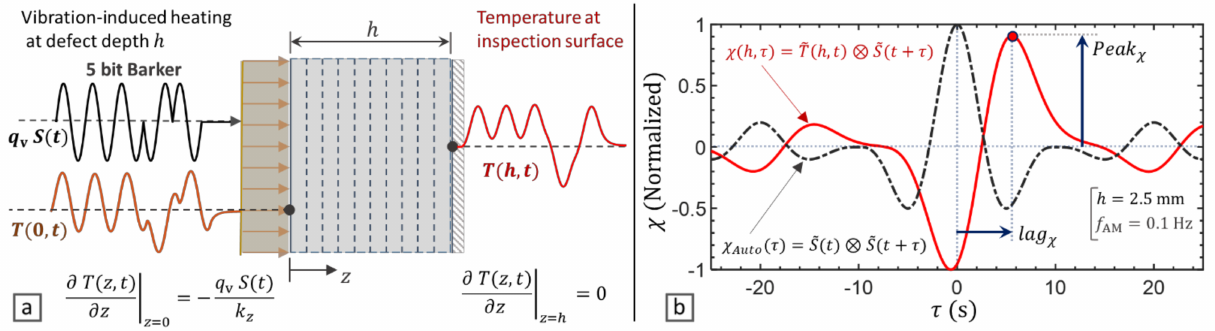
Figure 1. Analysis of the thermal response of a solid medium to subsurface heat sources and implementation of Vibro- Thermal Wave Radar (VTWR) using a 5 bit Barker coded waveform, ( a ) schematic model with heat dissipation-free boundary conditions, ( b ) VTWR for a 2.5 mm deep defect in a carbon fiber reinforced polymer (CFRP)